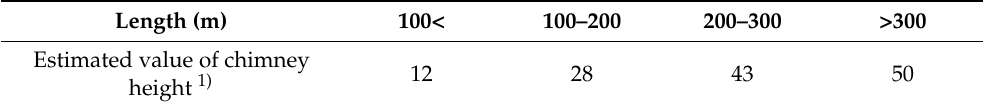
Table 11. Chimney heights of different ships. Length (m) 100< Estimated value of chimney height 1)